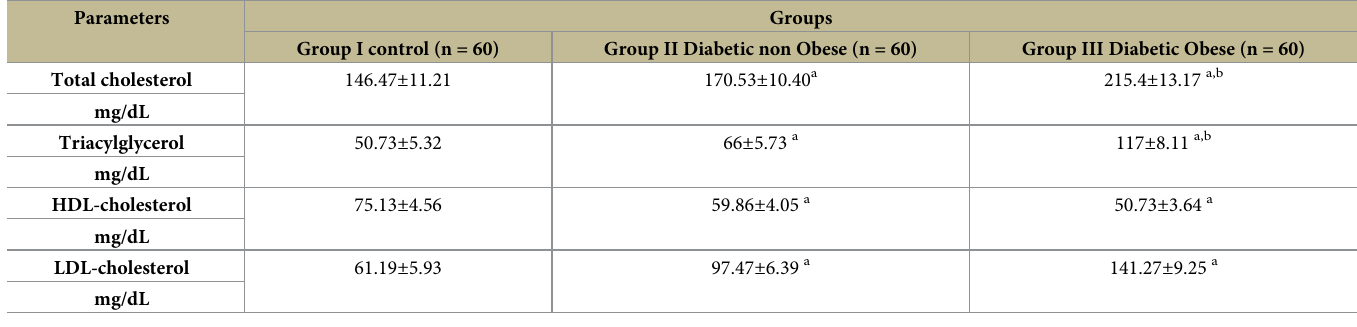
Table 2. Lipids profile levels in the different studied groups represented as mean ±